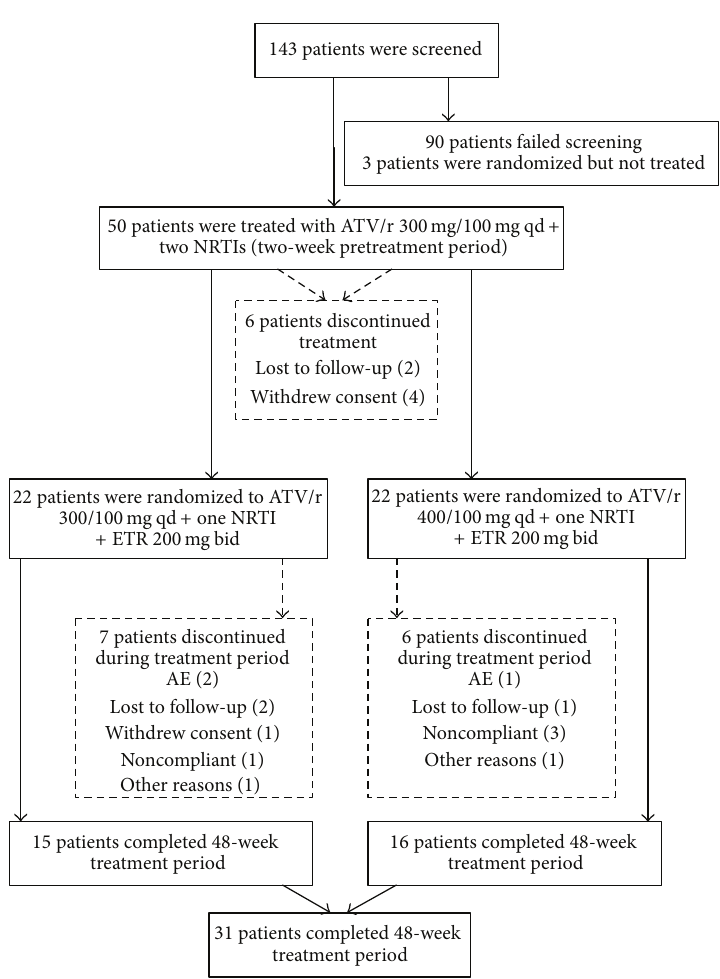
Figure 2: Patient disposition. AE: adverse event; ATV/r: atazanavir/ritonavir; ETR: etravirine; NRTI: nucleoside reverse transcriptase